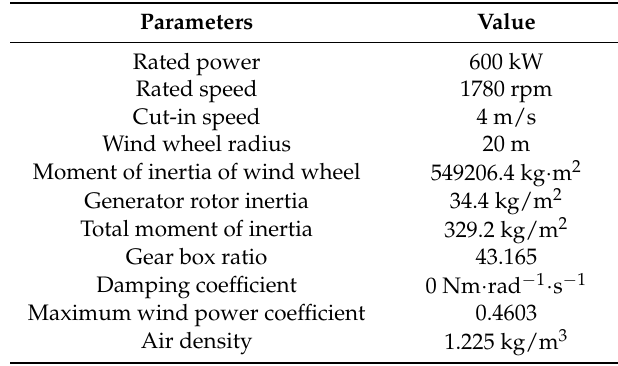
Table 3. Wind power plant data sheet.